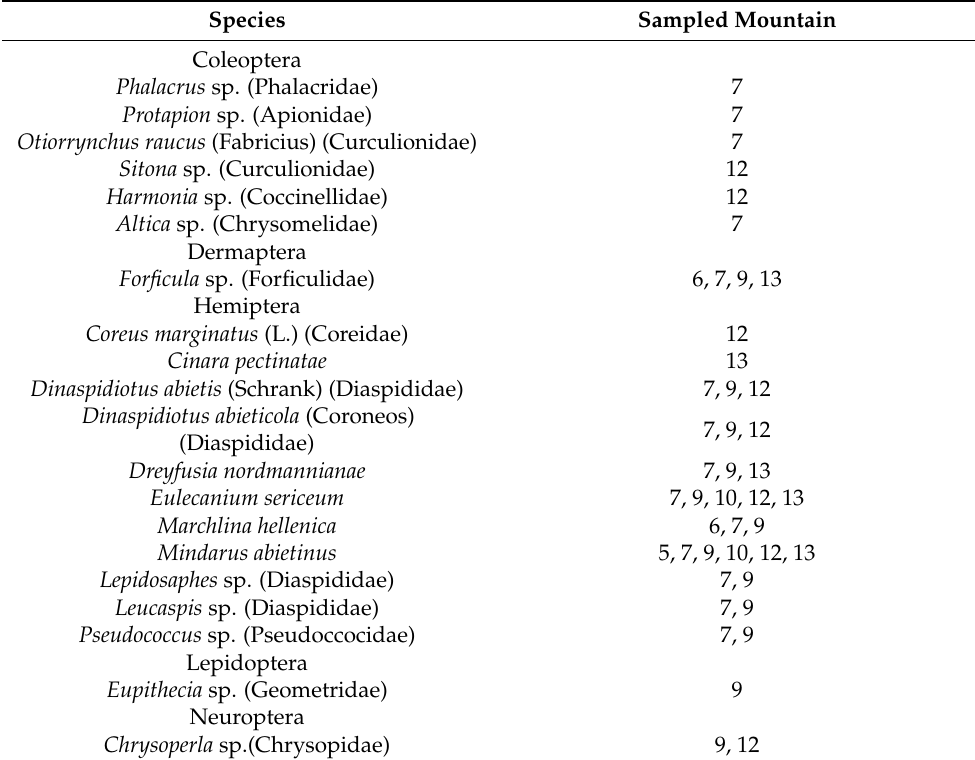
Table 7. Arthropods found on fir samples of south and central